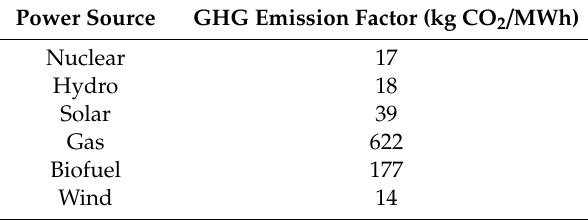
Table 1. Greenhouse gas emission factors from power generation sources [30] .